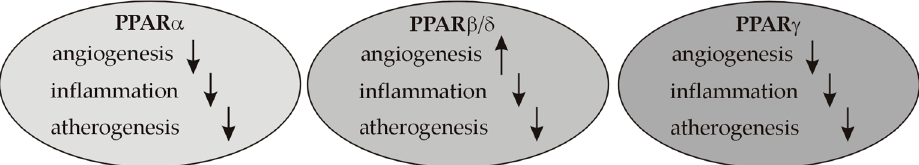
Figure 1. Simplified scheme of vascular PPAR actions with relevance for cardiovascular disease. ↑ indicates increase; indicates decrease.